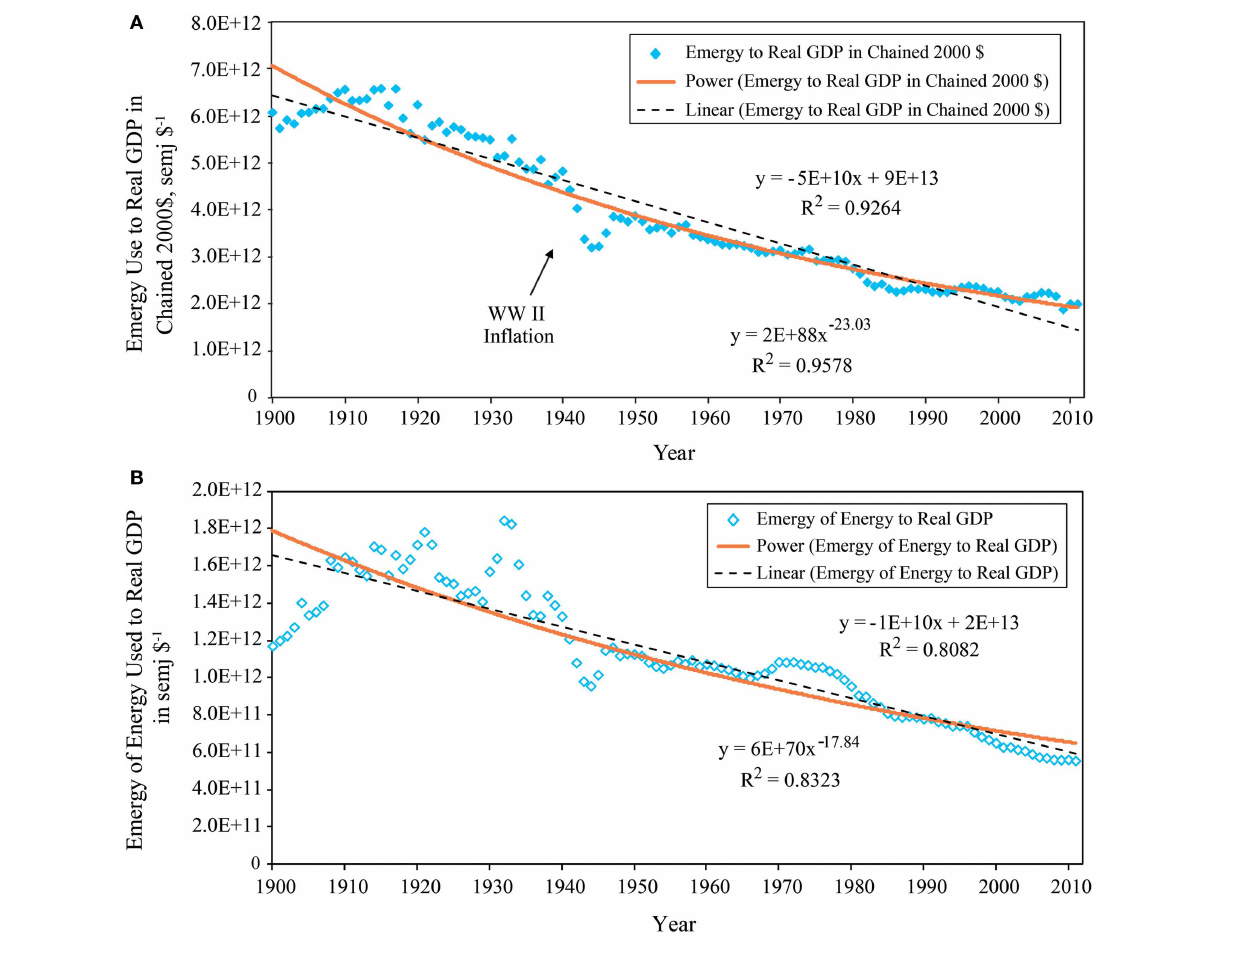
the fit of linear and power function relationships over time; (B) the ratio of the emergy of the energy consumed to real GDP in chained 2000 $ showing